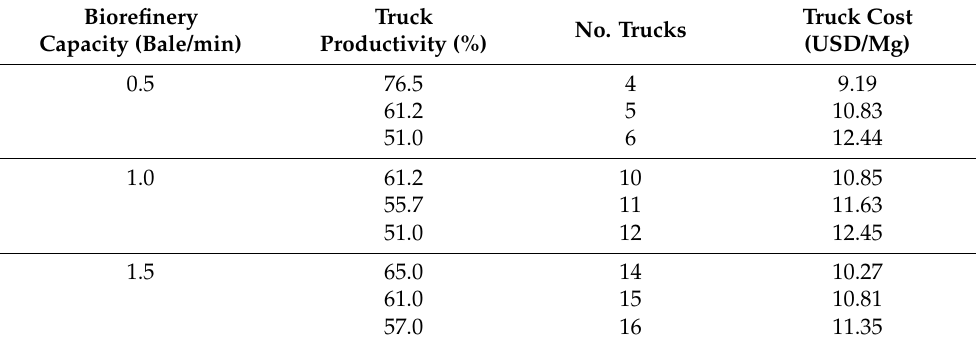
Table 9. Influence of truck productivity on cost (USD/Mg annual